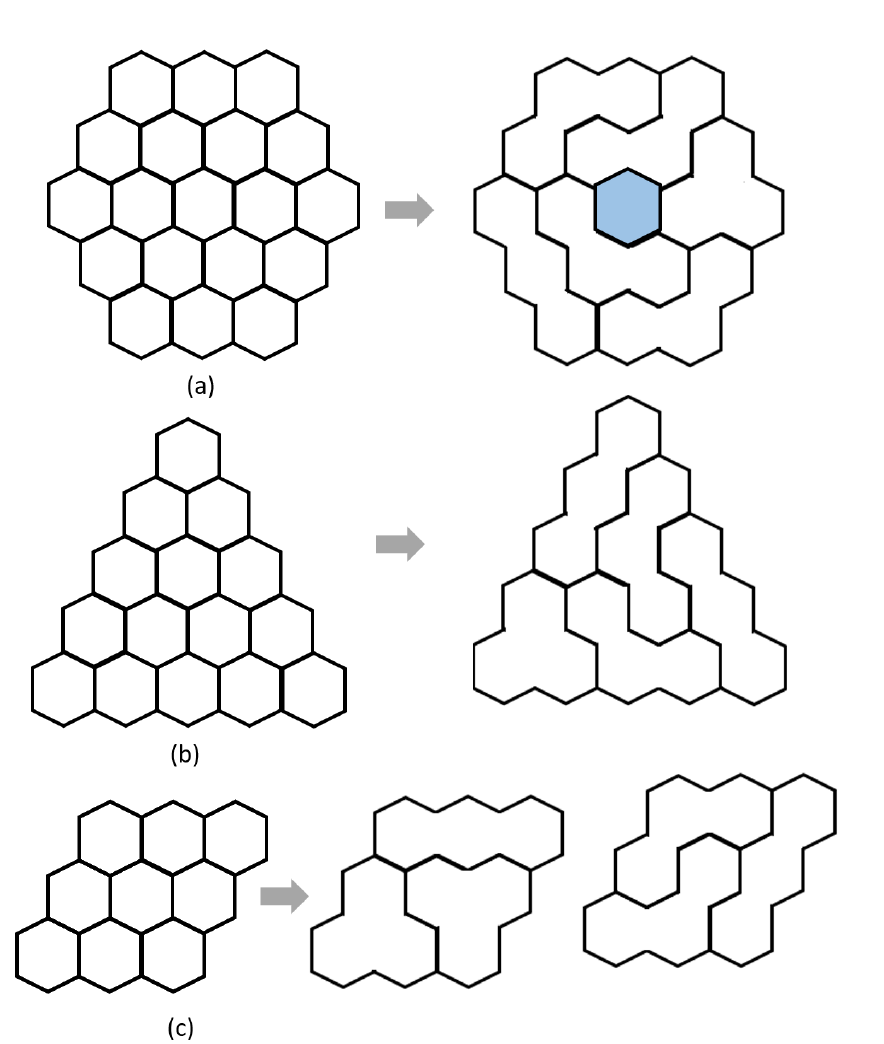
Figure 5. Different regular hexagon-based workspace in the form of: ( a ) ‘Honeycomb’; ( b ) ‘Hexagonal Triangle’; and ( c ) ‘Hexagonal